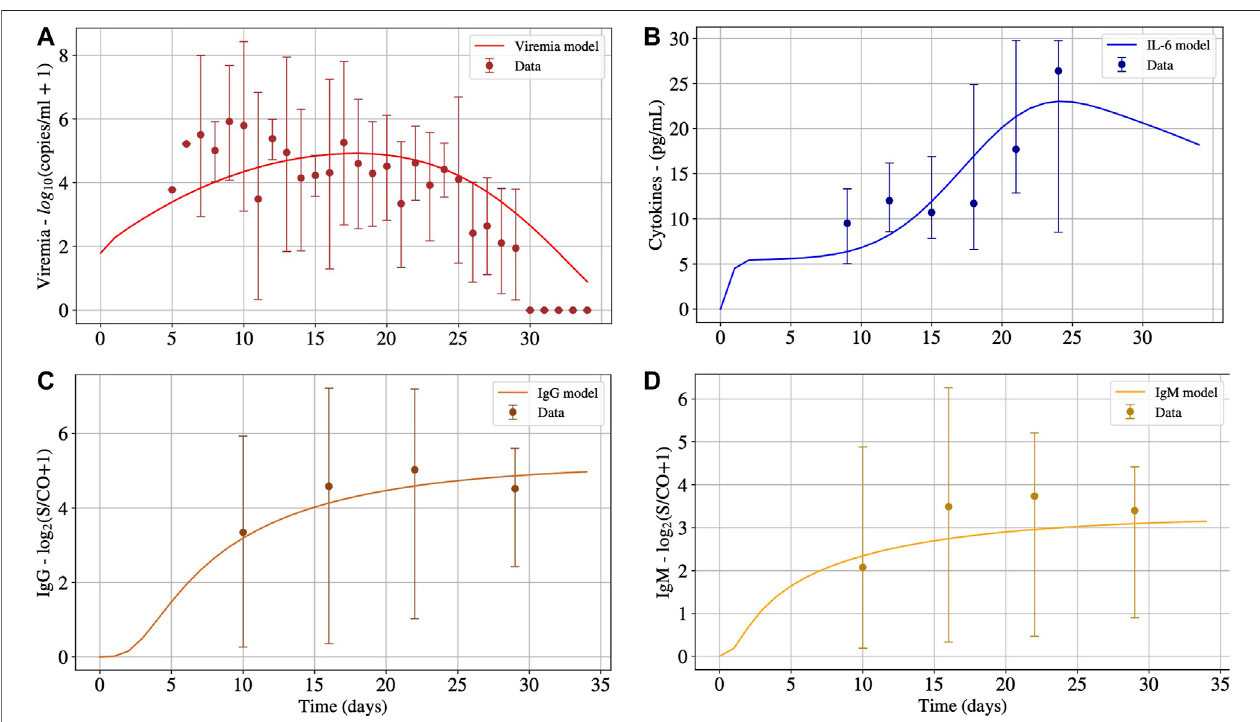
FIGURE 3 | The numerical results presented in Panels A, B, C and D represent the solution of Eqs 1 , 15 , 14 and 13 , respectively. These numerical solutions were fi ttedforpatients withCRSadjustingthevaluesof